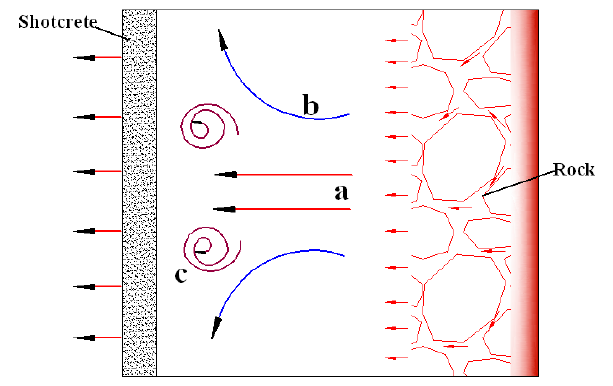
Figure 2. Heat transfer model: (a) linear type, (b) curve type, (c) spiral type.